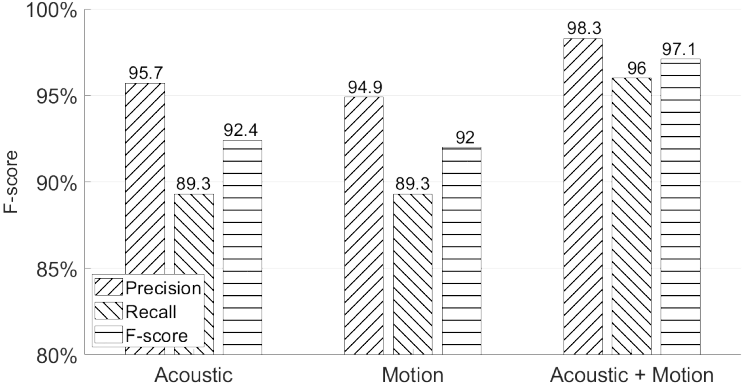
Figure 14. Overall system authentication